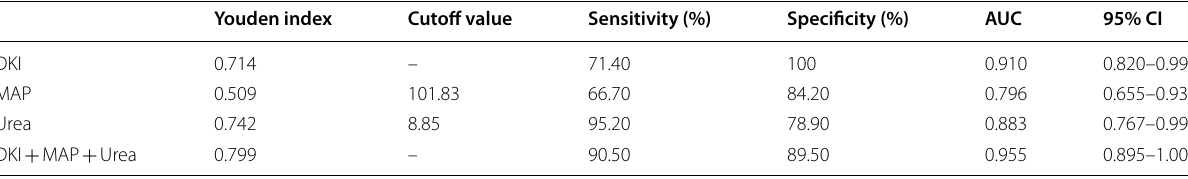
AUC area under the receiver operating characteristic curve, CI confidence